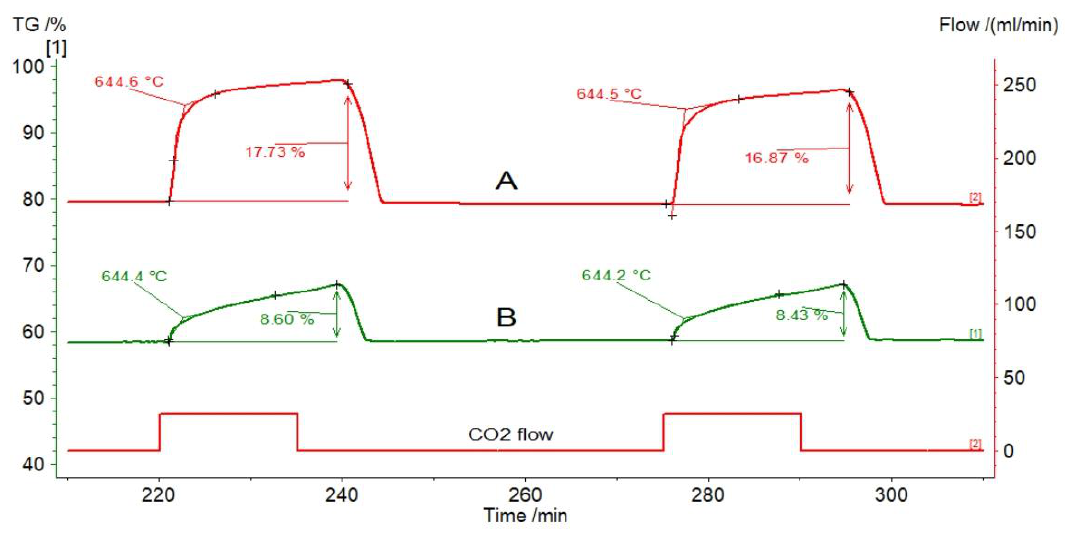
Figure 15. Relative mass changes for Stramberk limestone at the fifth and sixth calcium looping cycles: ( A ) without modification; ( B ) pretreated for 1 h at 1000 °C.